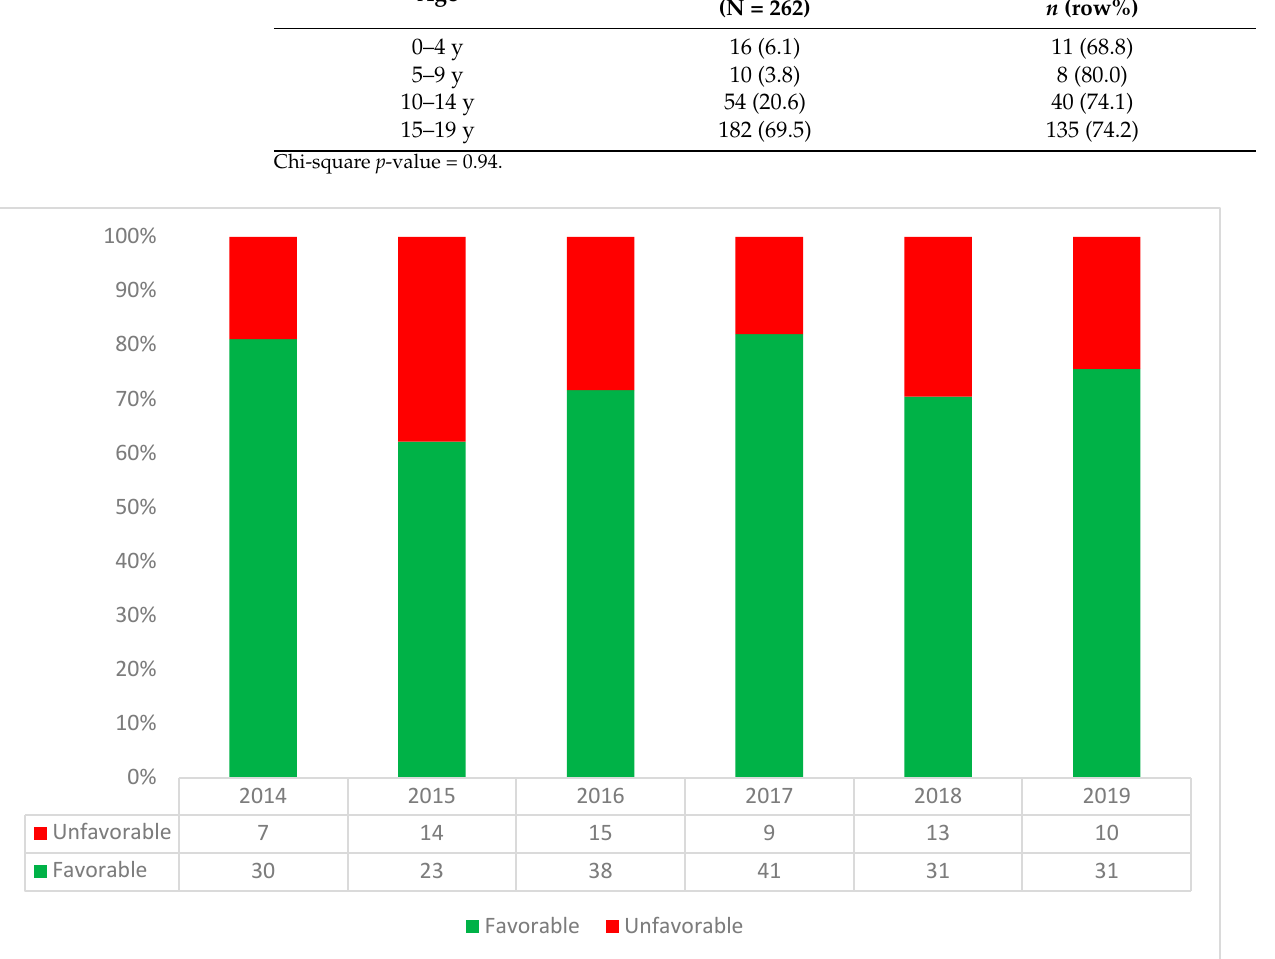
Figure 2. Annual treatment outcomes amongst children and adolescents receiving DR-TB treatment at a tertiary care hospital in Karachi, Pakistan between 2014 and 2019.